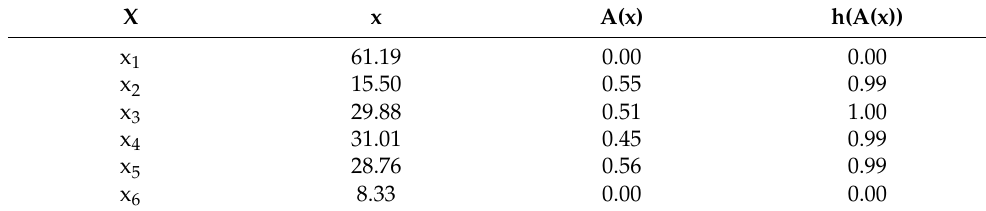
Table 1. Example of calculus of the fuzziness of a fuzzy set. X x A(x)